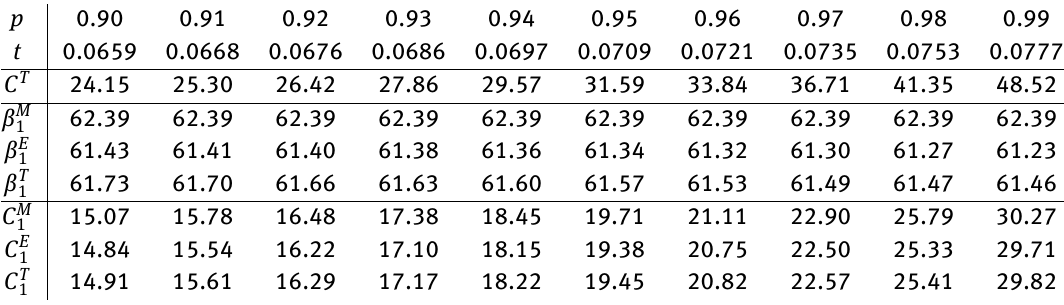
Table 1: The total loading ( C T ), three betas ( β 1 ’s in percentages), and allocated loadings ( C 1 ’s) to type 1 loss for ten p ’s and the corresponding t